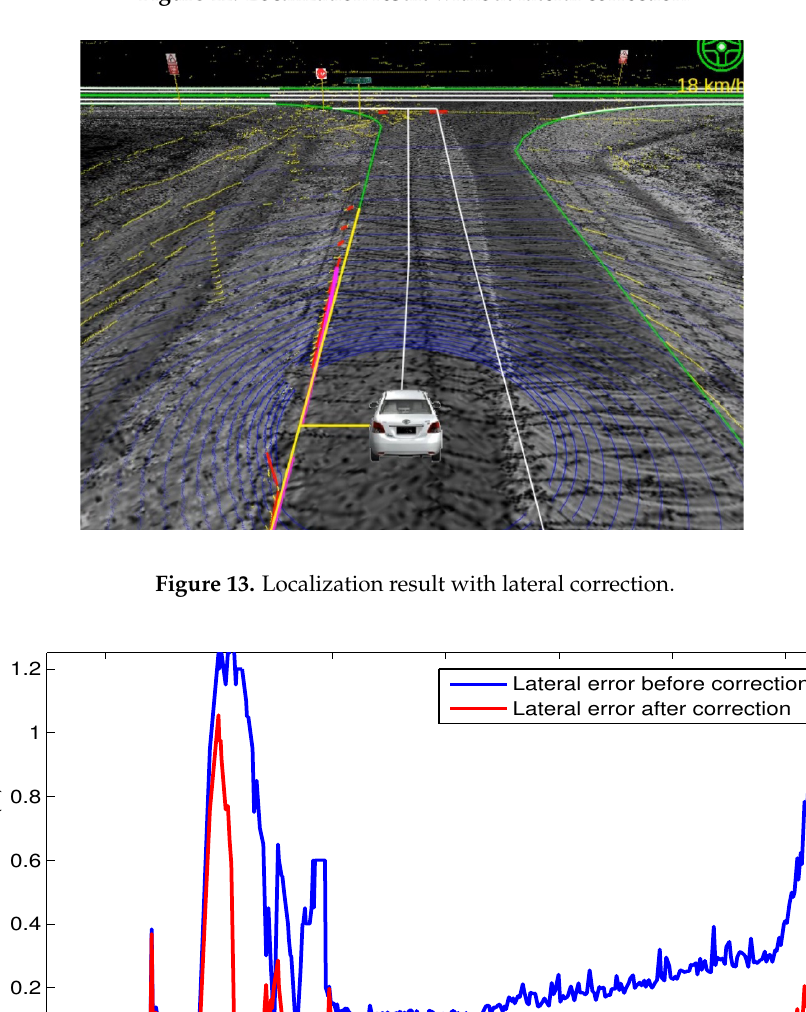
Figure 12. Localization result without lateral correction.